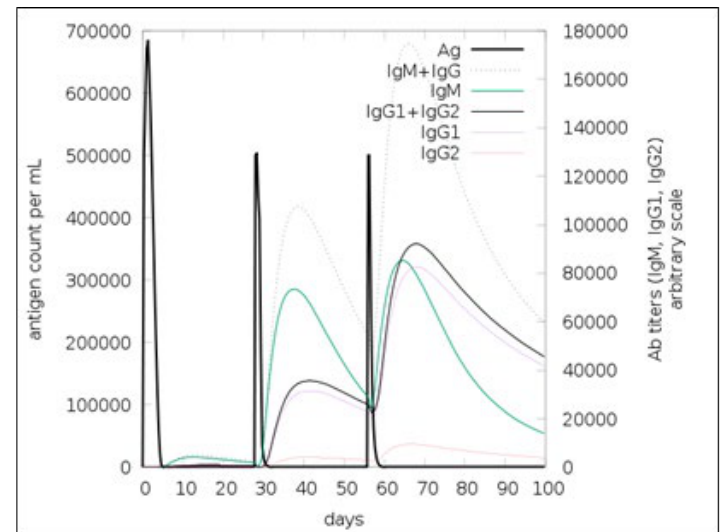
Fig. 10. Simulated antibody response upon vaccination